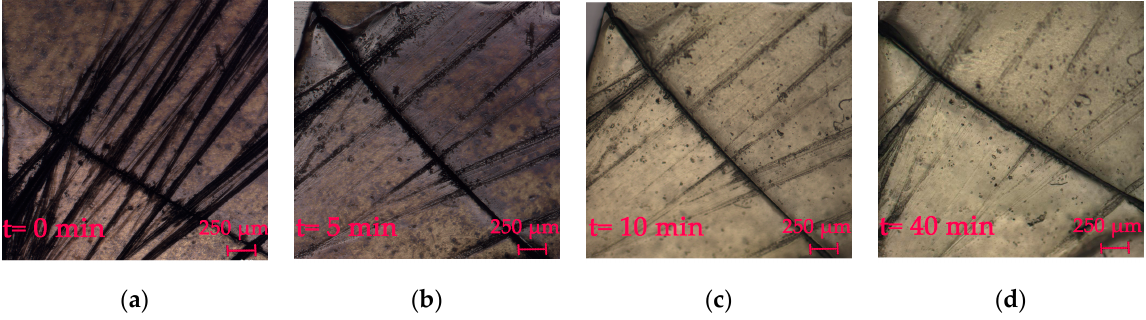
Figure 10. Optical microscopic images of healing accelerated by HCl of copolymer 3 (AAm/AAc = 14.5/84.5): ( a ) t = 0 min; ( b ) t = 5 min; ( c ) t = 10 min; ( d ) t = 40 min.